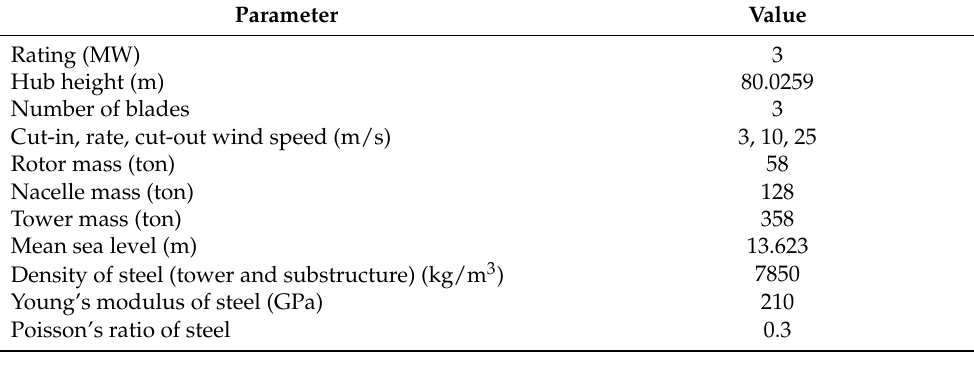
Table 2. 3 MW-capacity wind turbine main parameters.